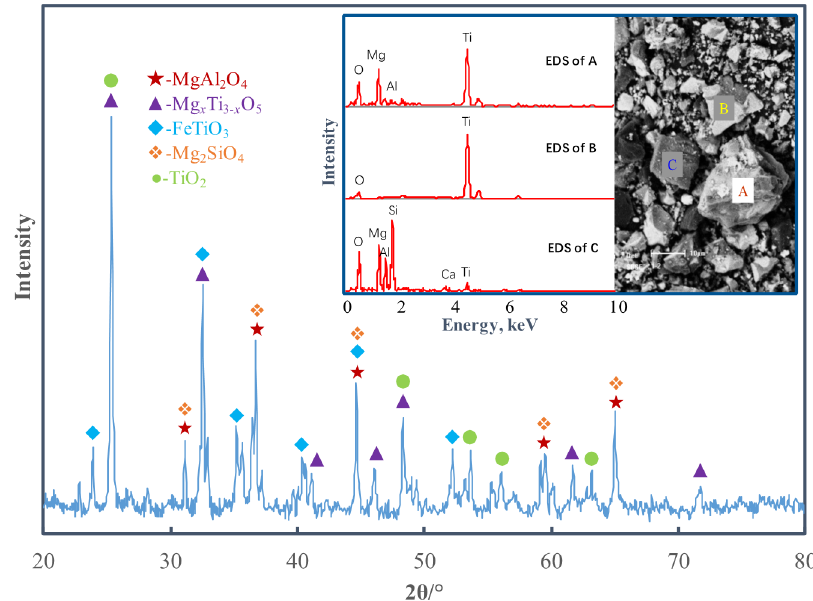
Figure 2. XRD pattern and EDS analysis of separated tailings.